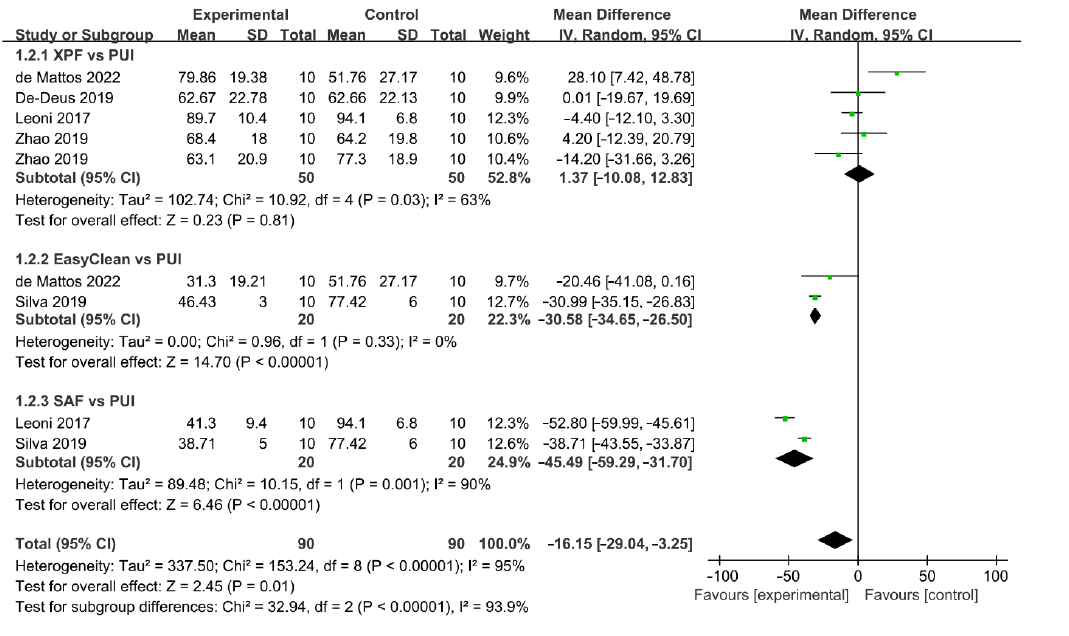
Figure 8. Forest plot and meta ‐ analysis of comparison between LAI and PUI [15,41].